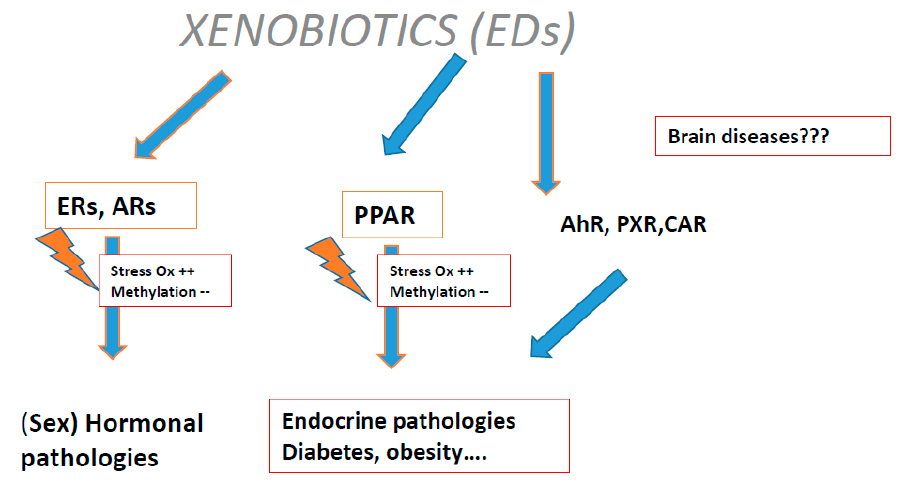
Figure 3. The link between oxidative stress and methylation disturbance: Xenobiotics (endocrine disruptors (EDCs)) interactions with some receptors.